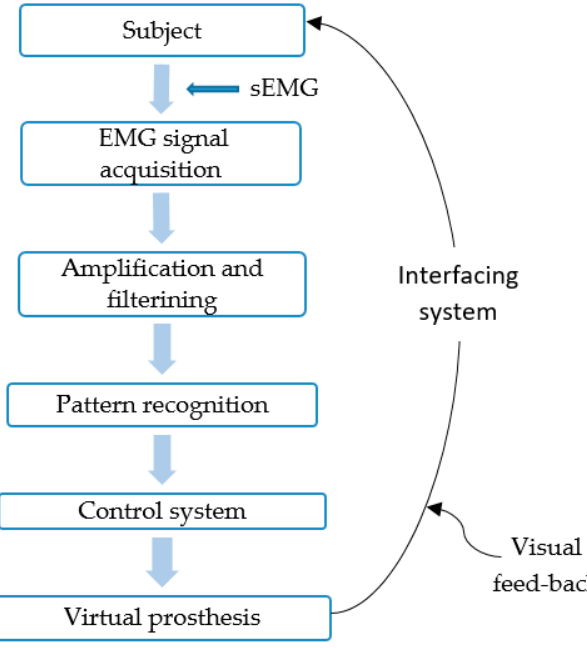
Figure 4. General representation of virtual prosthesis process.